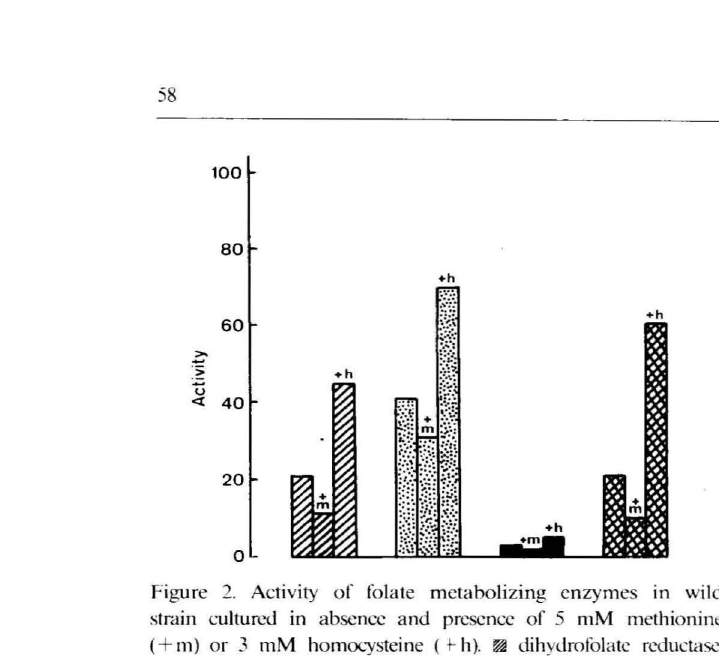
\\'as added at the stan of culture.